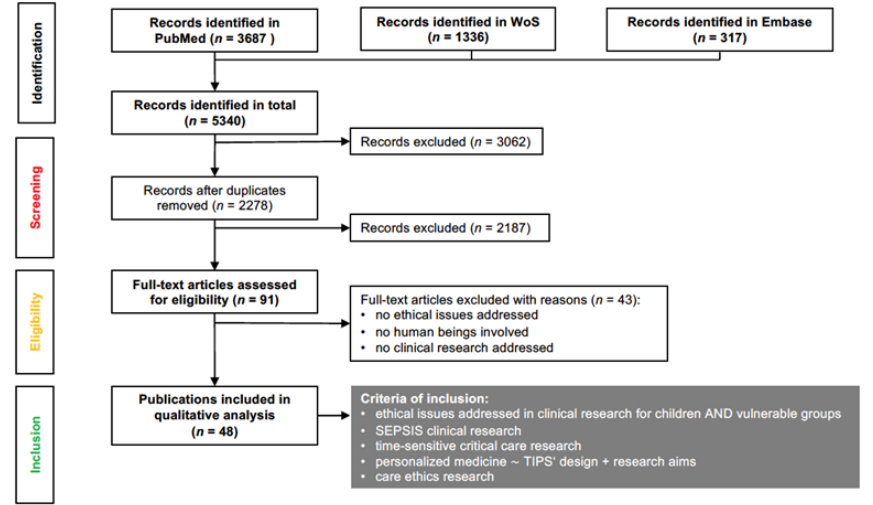
Figure 2. Flow chart detailing literature search and criteria of inclusion.